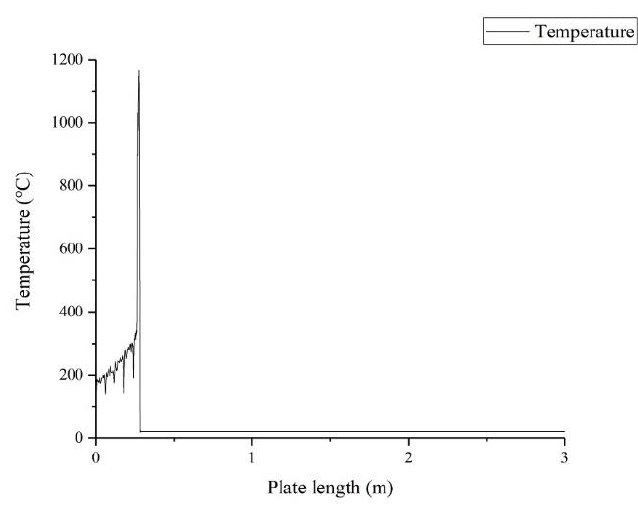
Figure 7. Temperature profile on the cut path at 1 s of W18Cr4V cutting.